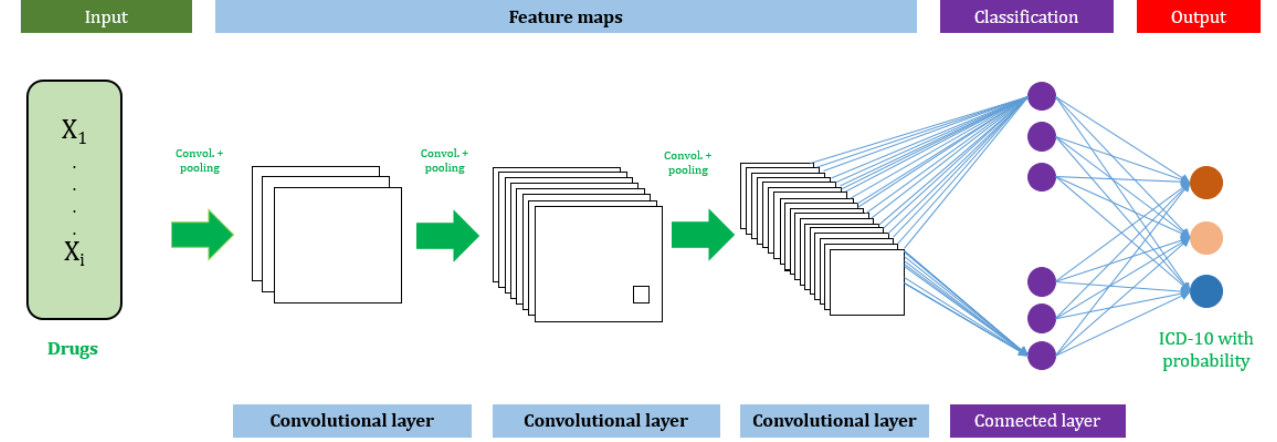
Figure 5. Architecture of the deep ‐ ADCA model.